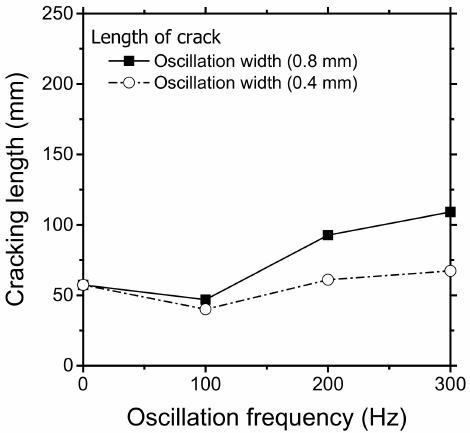
Figure 7. Measured length of the crack for different oscillation widths at varying frequencies. The specimen was prepared with an infinite-shaped pattern (laser power: 900 W, oscillation frequency: 200 Hz, and welding speed: 3 m/min).